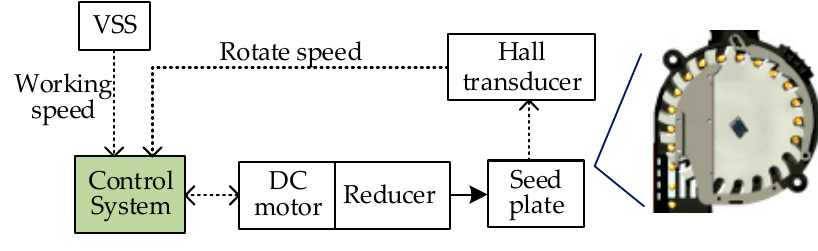
Figure 7. Schematic of seed metering device.